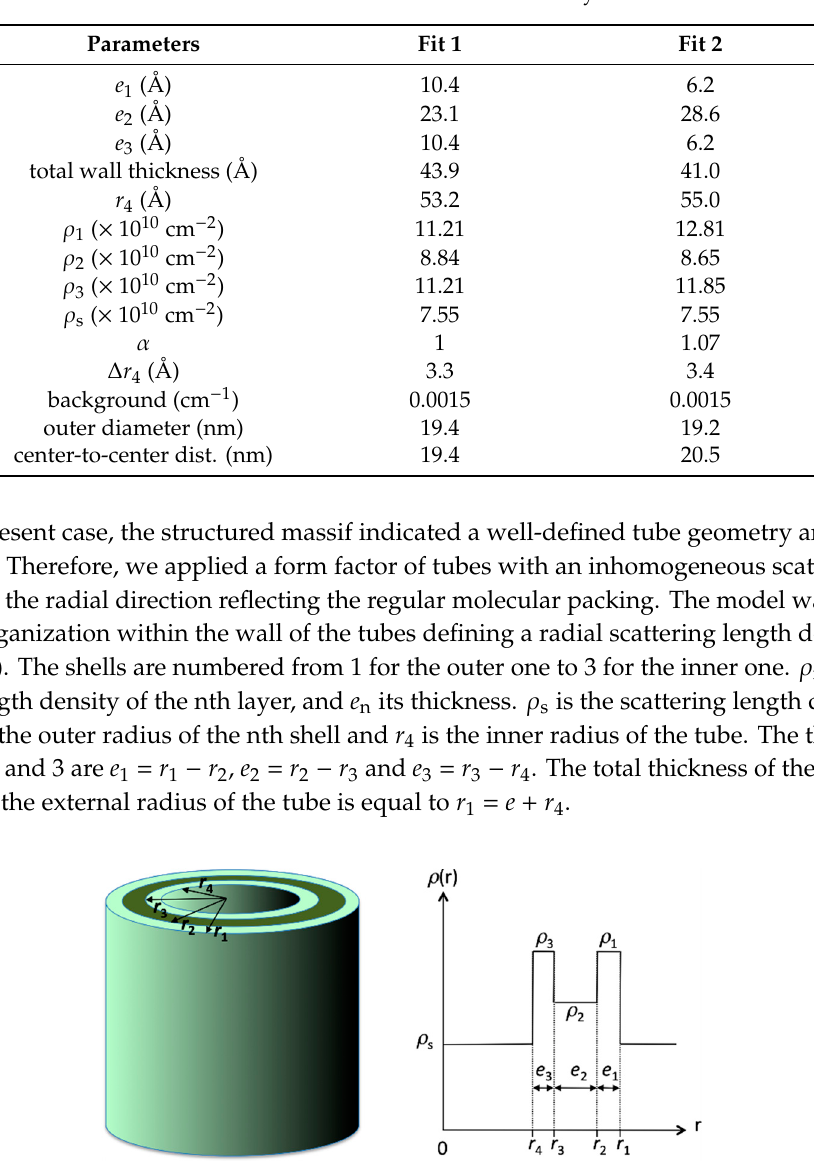
Table 1. Parameters of the fits with the three-layer model.